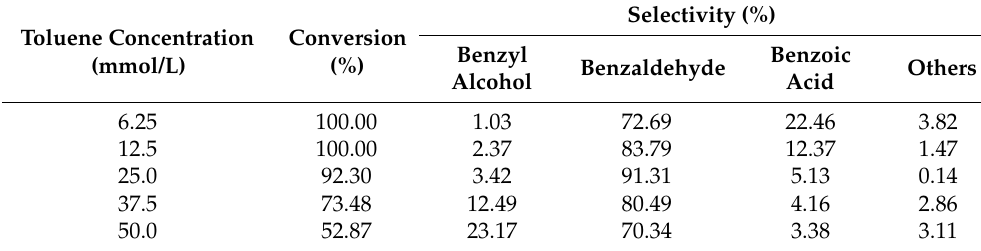
Table 2. Effects of the initialized toluene molar.